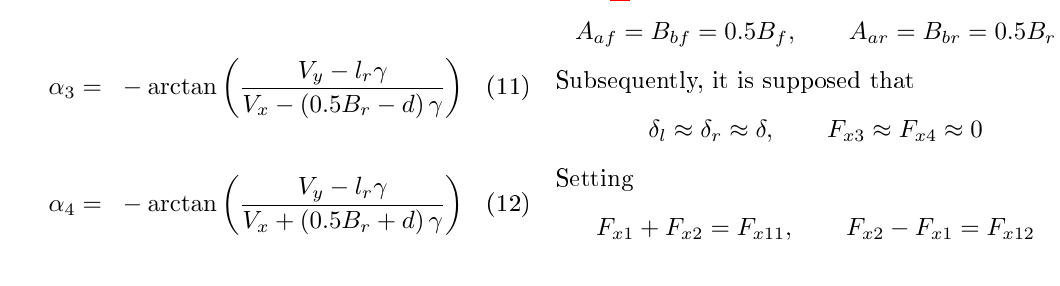
Fig. 2: Yaw rate and lateral acceleration